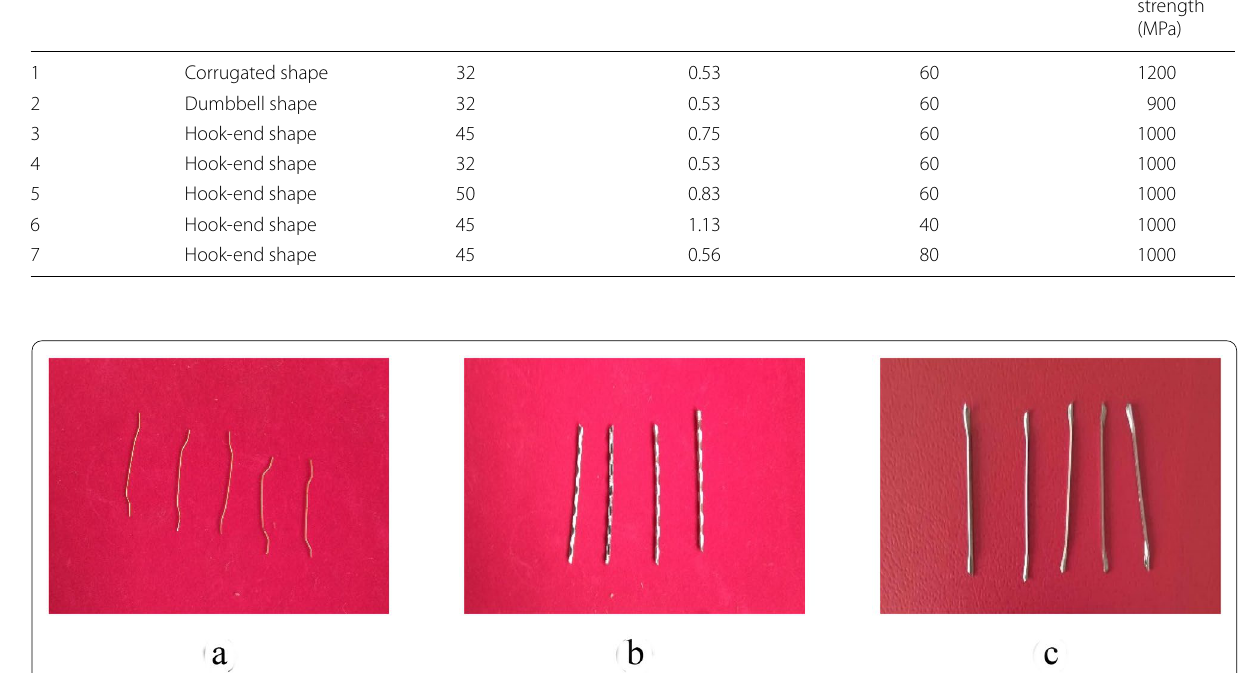
Fig. 1 Shapes of steel fiber: a hook-end shape, b corrugated shape, and c dumbbell